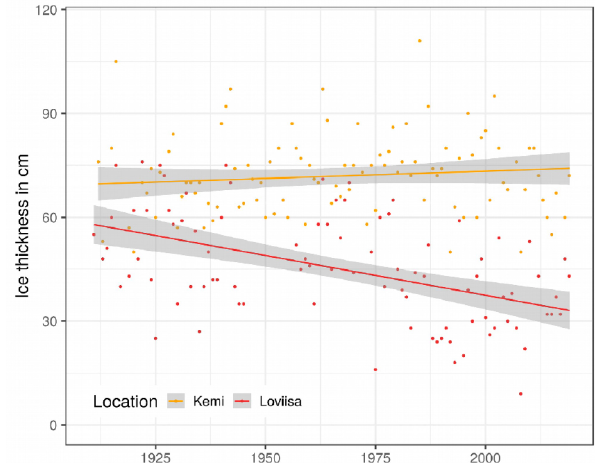
Figure 16. Level ice thickness at Kemi, Finland, and Loviisa, Fin- land, during 1912–2019. Dots are the annual mean, and lines are the linear trend with 95% confidence intervals. Data are available from the ice service of the Finnish Meteorological Institute, Helsinki, Finland, upon request (https://en.ilmatieteenlaitos.fi/ice-conditions, last access: 6 March 2022).